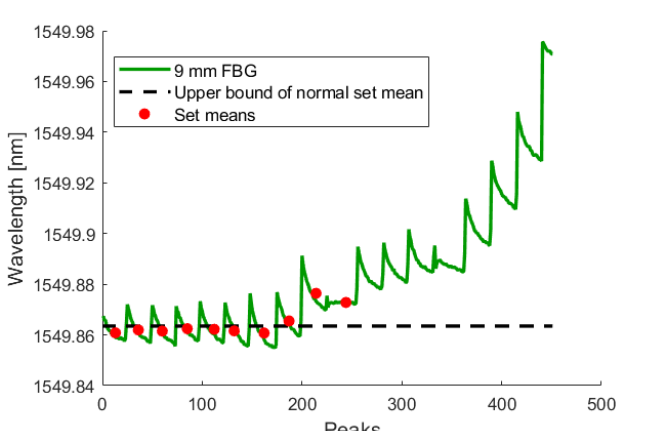
Figure 17. Crack detection analysis during low-amplitude cyclic loading for the FBG embedded 9 mm from the notch